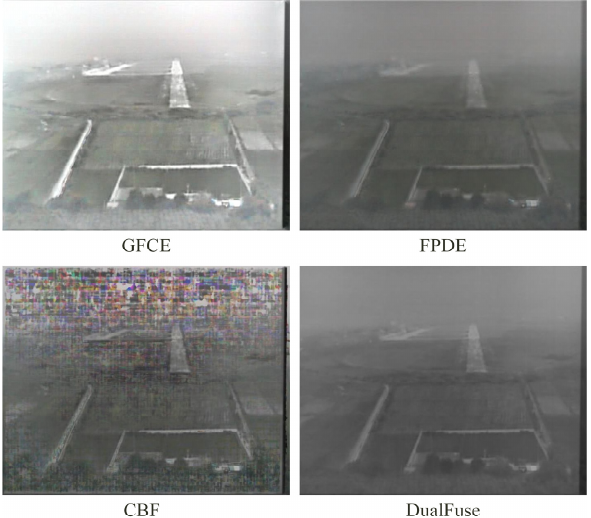
Figure A1 complements low-quality imaging results. The imaging from GFCE and CBF has overexposure and light spots, respectively. FPDE reduces the imaging resolution, and DenseFuse can replace DualFuse.